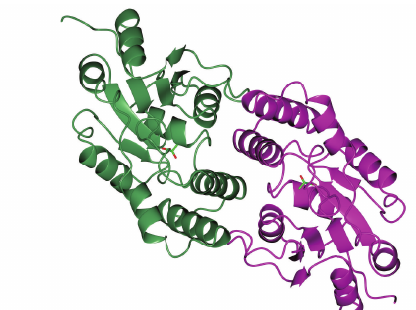
Figure 3: A ribbon diagram of the structure of the Sulfolobus dehalogenasedimerwitheachmonomershowninadifferentcolour. The monomer has a core domain with a Rossmann-like fold of six- stranded parallel 𝛽 -strands surrounded by five 𝛼 -helices and three 3 10 helices and a subdomain composed of 𝛼 -helices. A substrate mimic is shown in the two active sites as a stick model, located between the two domains of each monomer (PDB code 2W11). The figure was constructed using CCP4mg